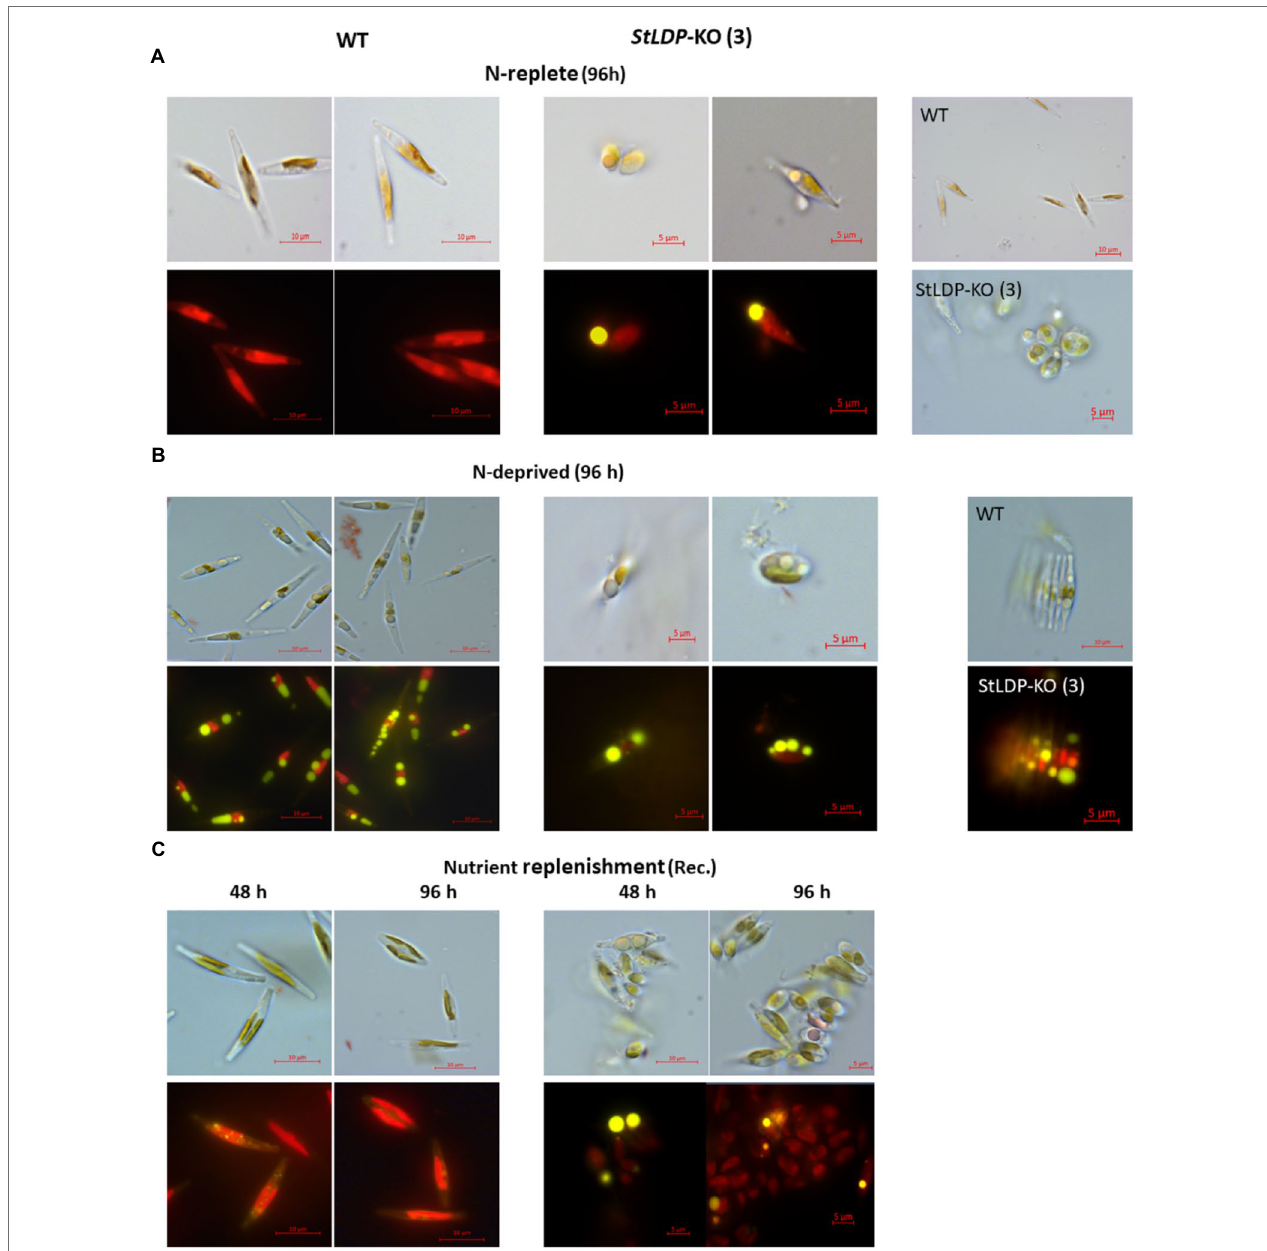
FIGURE 4 | Micrographs of Pt1 wild-type and StLDP -KO (3) cells under N-replete conditions (A) , N deprivation (B) , and following nutrient replenishment (C) . DIC micrographs and fluorescence micrographs of Nile Red stained cells (×1,000 magnification) are shown for each condition (indicated). Lipid droplets are visible as bright yellow fluorescent bodies. Pt1 wild-type and StLDP -KO (3) lines were cultivated in an incubator shaker with a CO 2 -enriched atmosphere (100 ml/min) at 22 ° C with shaking speed of 120 rpm under a light intensity of 50 μ mol photon m − 2 s − 1